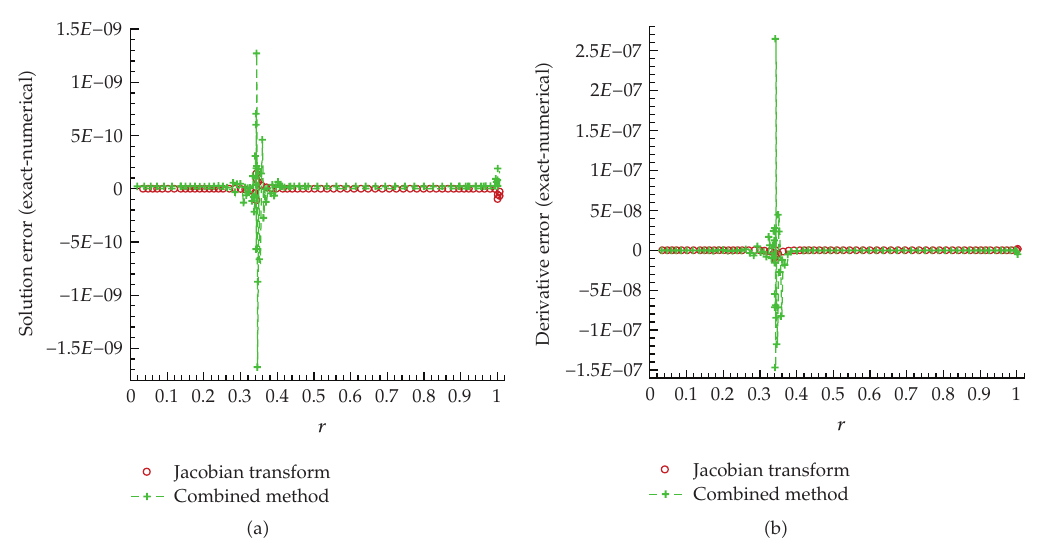
Figure 8: Comparisons of the error in solution φ (cid:6) a (cid:7) and in the derivative of the solution ∂φ/∂r (cid:6) b (cid:7) for the sample geodynamo problem. Results were obtained separately from the sixth-order compact schemes with the Jacobian transformation at L (cid:9) 28 on a nonuniform grid with 190 points.